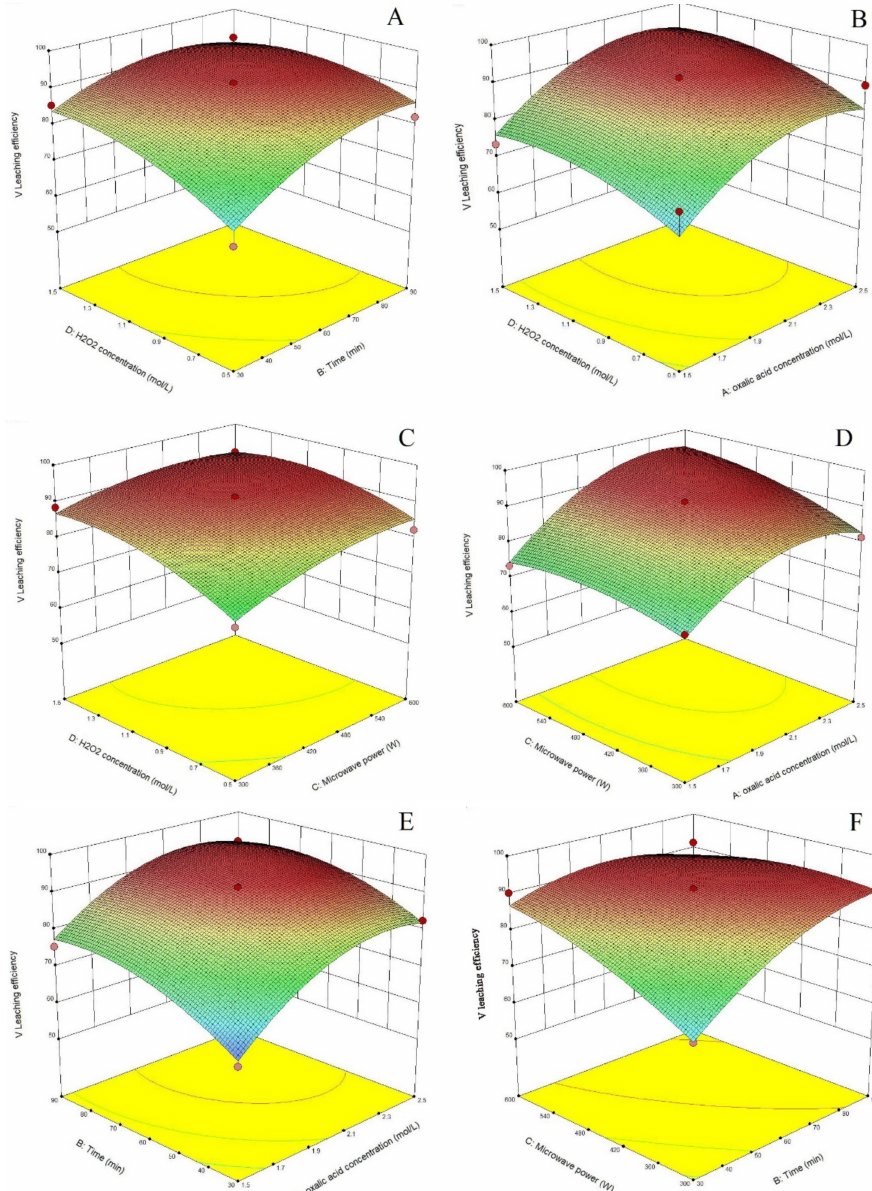
Figure 4. 3D response surface plots of the effect of various parameters on V extraction: ( A ) Relation- ship of H 2 O 2 concentration and leaching time; ( B ) Relationship of H 2 O 2 concentration and C 2 H 2 O 4 concentration; ( C ) Relationship of H 2 O 2 concentration and microwave power; ( D ) Relationship of C 2 H 2 O 4 concentration and microwave power; ( E ) Relationship of C 2 H 2 O 4 concentration and leaching time; ( F ) Relationship of leaching time and microwave